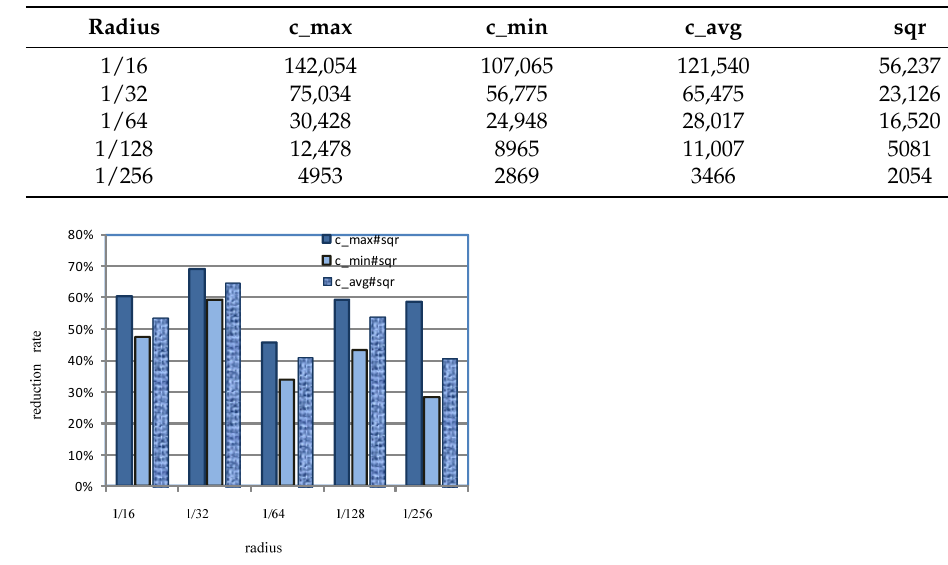
Figure 13. The reduction rates of confirmation points. 6.4. Discussion For a given targeted area, the performance of O_PtInPy, L_Rect, c_, and sqr in iden- tifying inner points was compared. For City 1, O_PtInPy generated 12.47 times the can- didate points with respect to the inner points, and L_Rect generated 1.55 times the can- didate points with respect to the inner points. The values for c_ and sqr in City 1 ranged from 2.02 to 1.22 and from 1.38 to 1.01. For c_ and sqr, different subarea plans generated